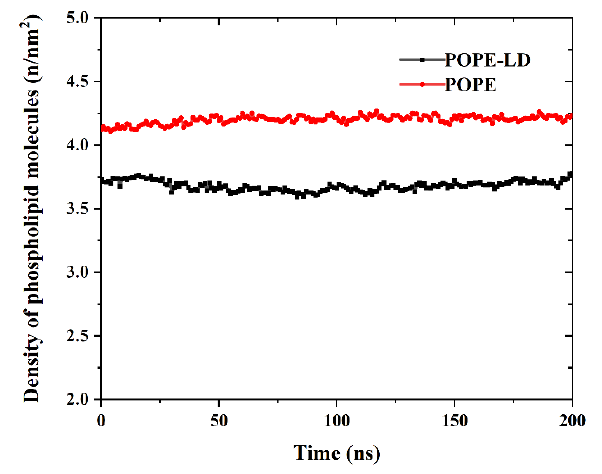
Figure 6. Change in phospholipid molecular density of POPE membrane.